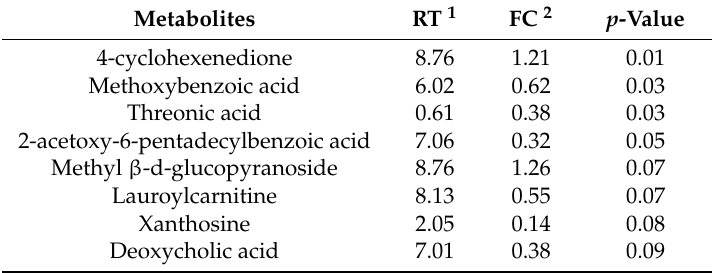
Table 3. Fold changes of differential ruminal metabolites of beef steers fed no or 15 g/d of live yeast product.